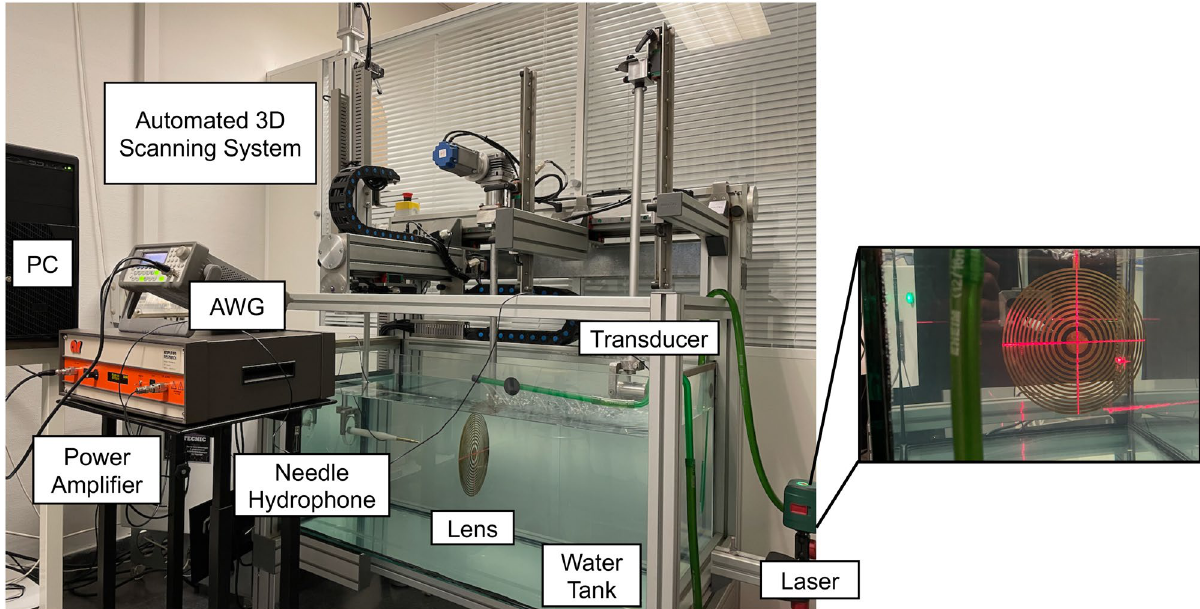
Figure 4. Picture of the experimental set-up (left side) and inset with a picture of the system position and level calibration using an self-leveling laser device (right